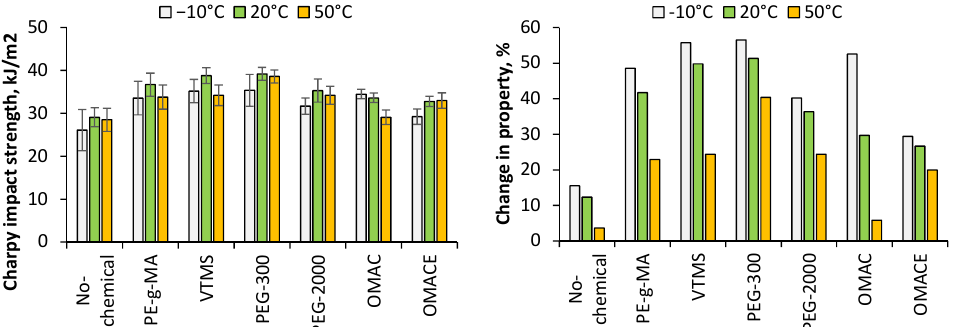
Figure 10. The Charpy impact strength of nano-cellulose reinforced PLA composites and the prop- erty